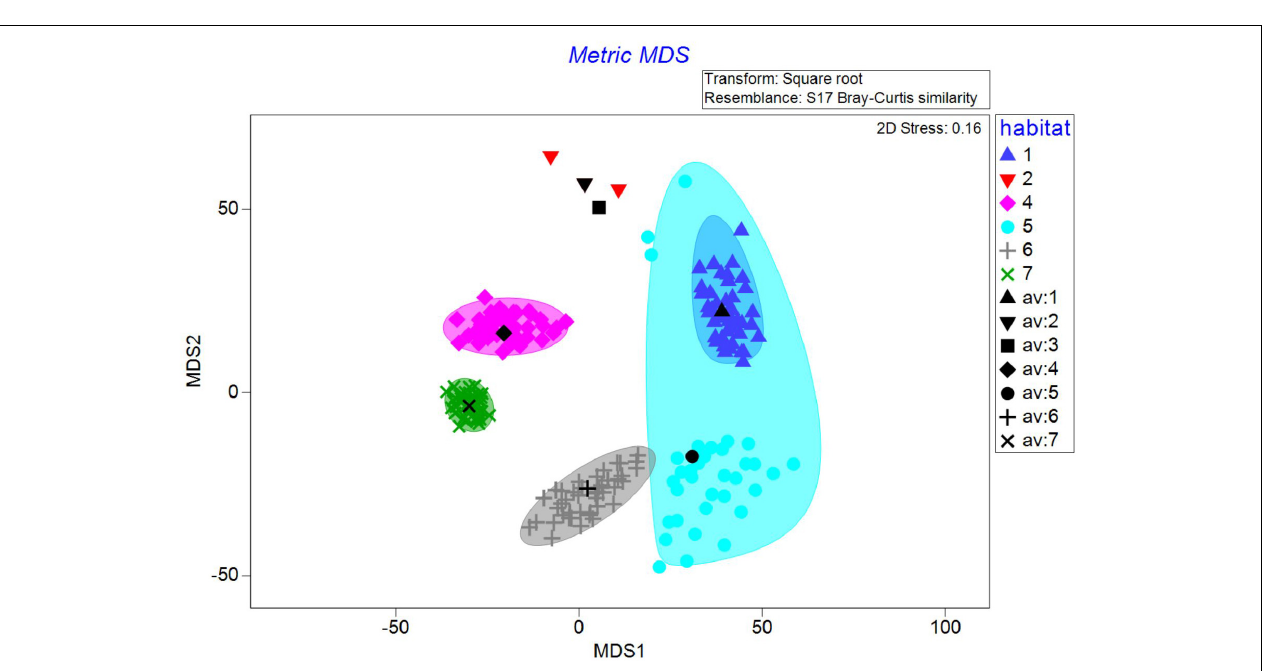
Frontiers in Marine Science |